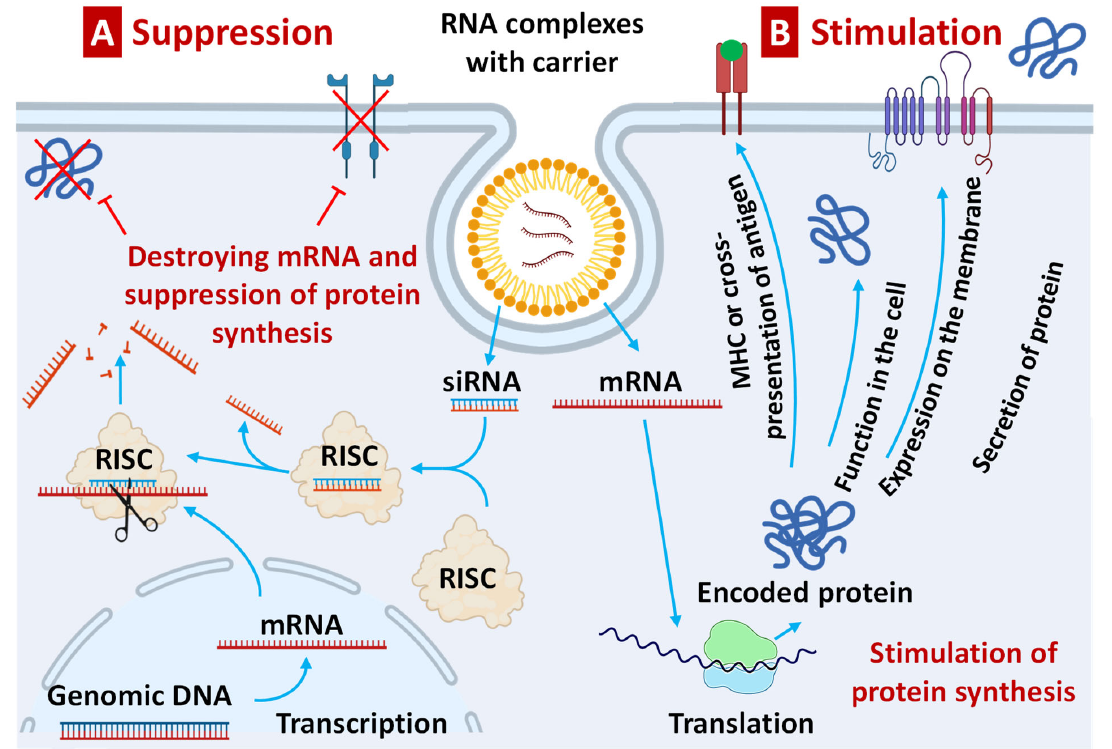
Figure 7. Therapeutic action of RNA constructs.(A) Suppression of protein synthesis by short interfering RNA (siRNA) or single-stranded micro-RNA (miRNA) through the mechanisms of the RNA interference. (B) Initiating of protein synthesis by translating the information embedded in delivered mRNA into a protein with the participation of the intracellular machinery of protein synthesis.